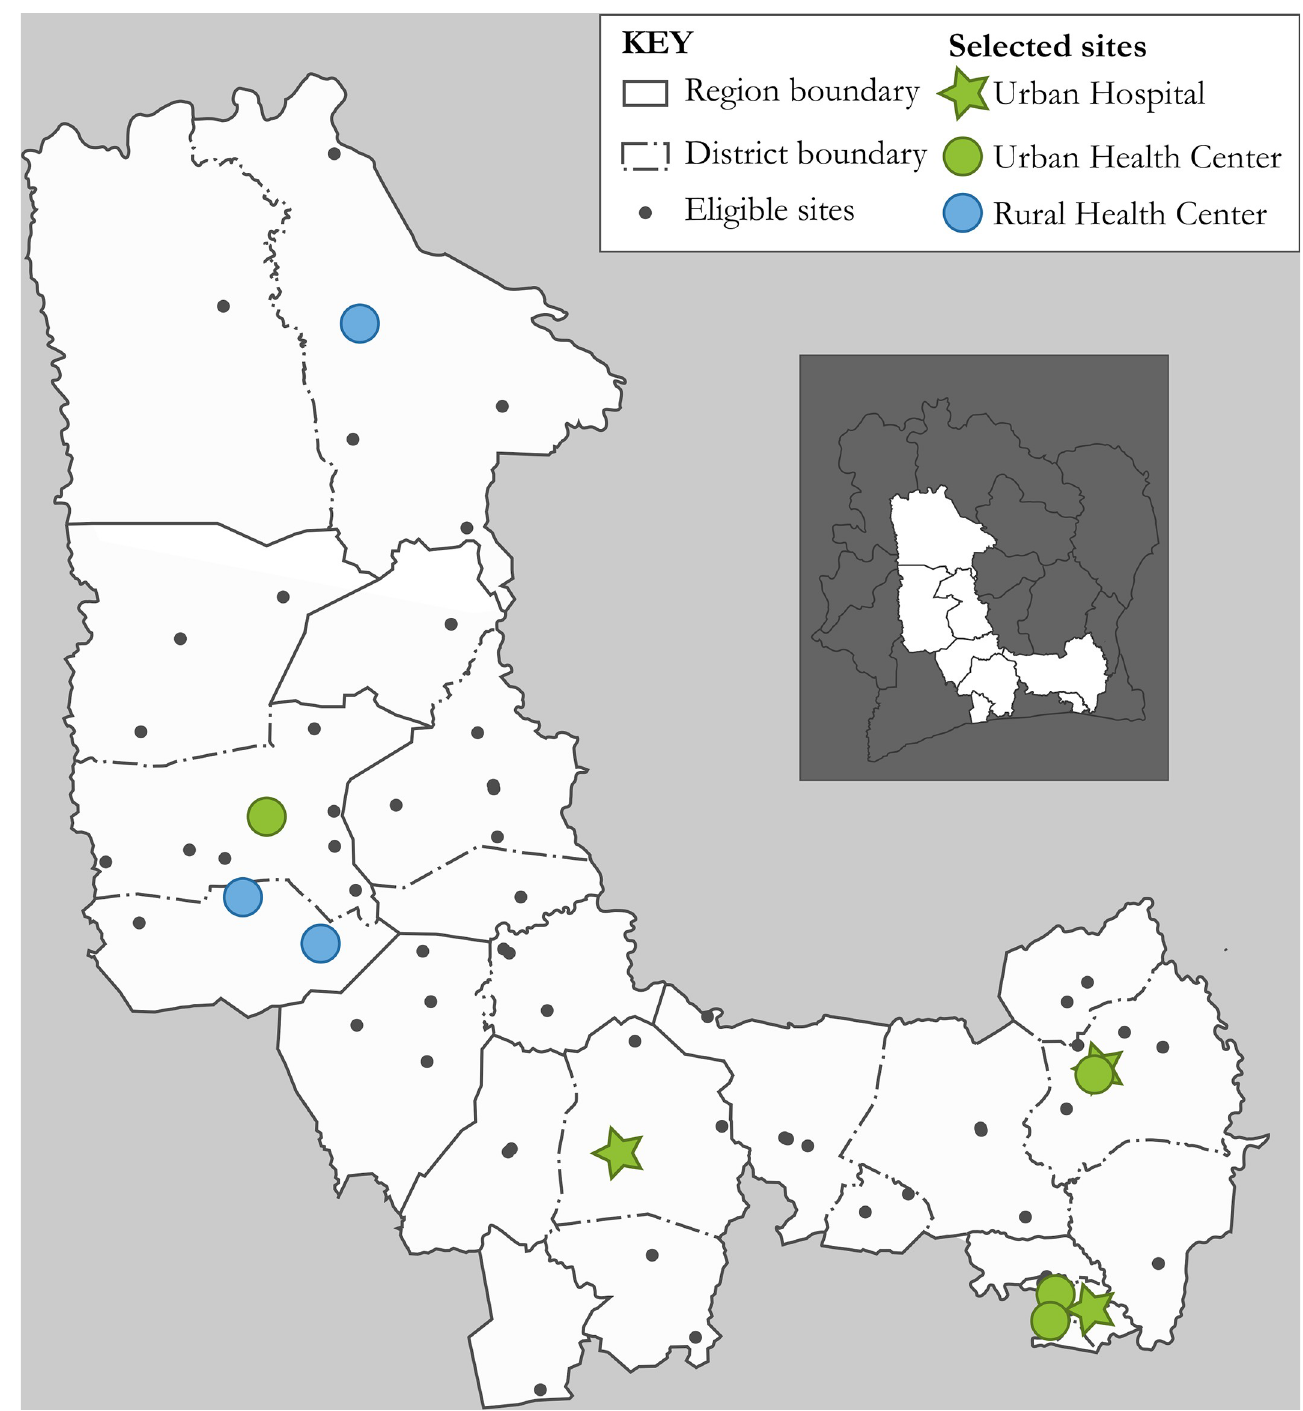
Fig 1. Map of included and eligible facilities in Coˆte d’Ivoire. (Figure created by the authors. Republished from [25] under a CC BY license, with permission from the International AIDS Society, original copyright 2020).